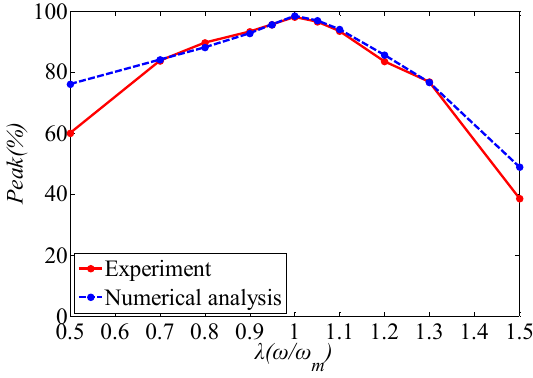
Figure 13. Control effectiveness of experiment and numerical analysis.